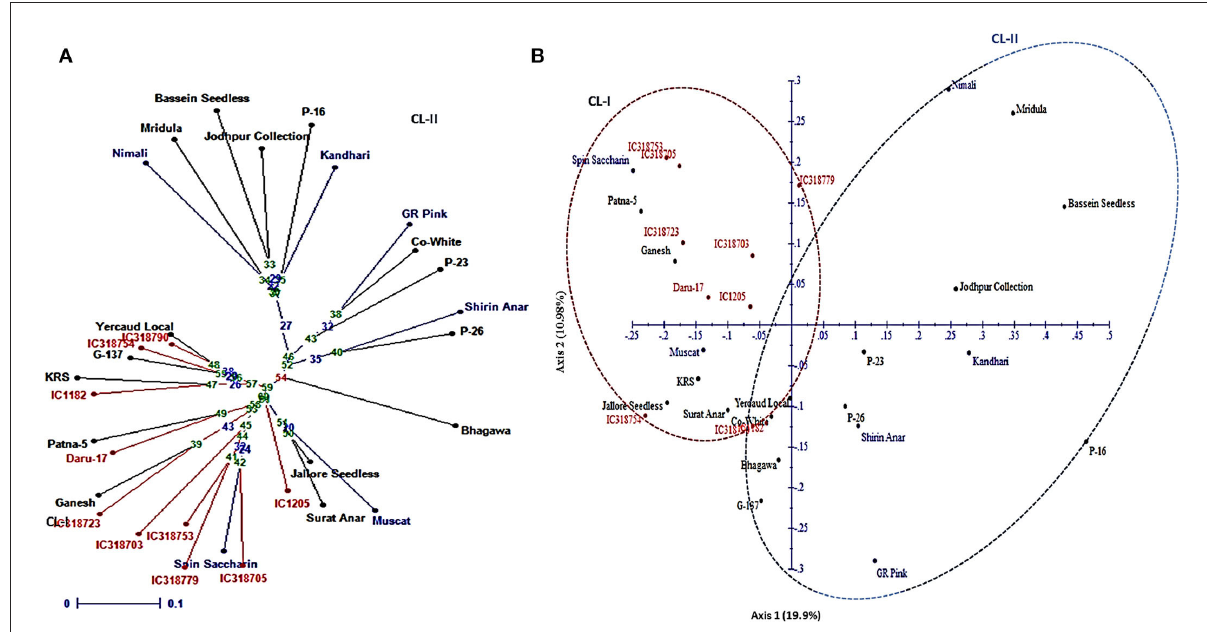
FIGURE8 The Neighbor-joining tree (A) and the PCA plot (B) showing genetic relationships among 31 pomegranate genotypes based on 24 PIP markers.